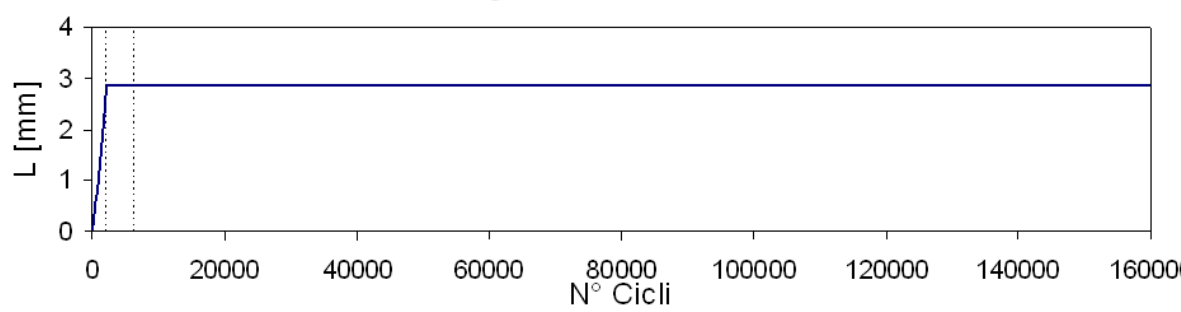
Figura 22: Lunghezza della cricca rilevata in funzione del N° di cicli.